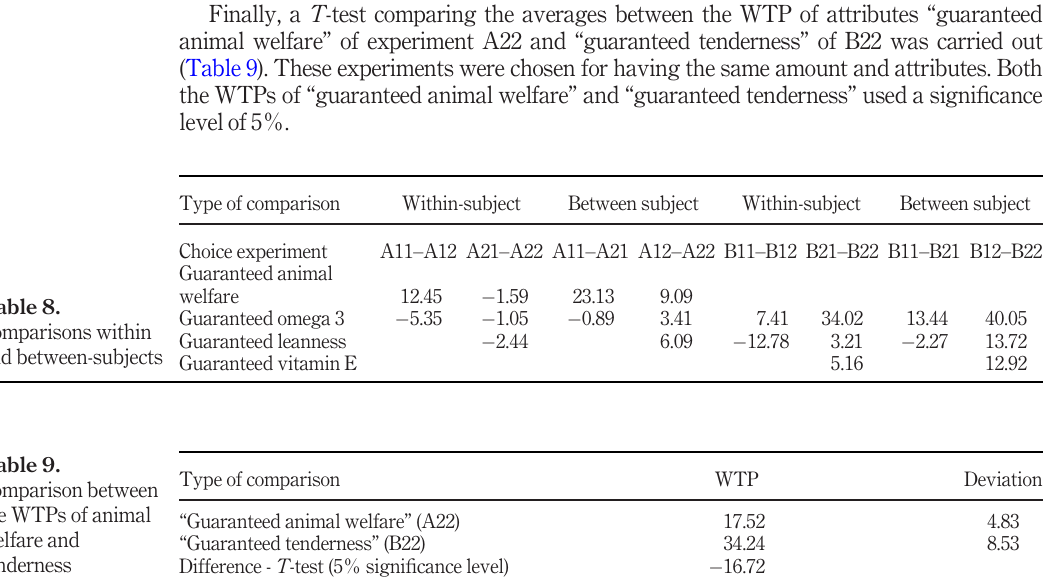
Table 9. Comparison between the WTPs of animal welfare and tenderness